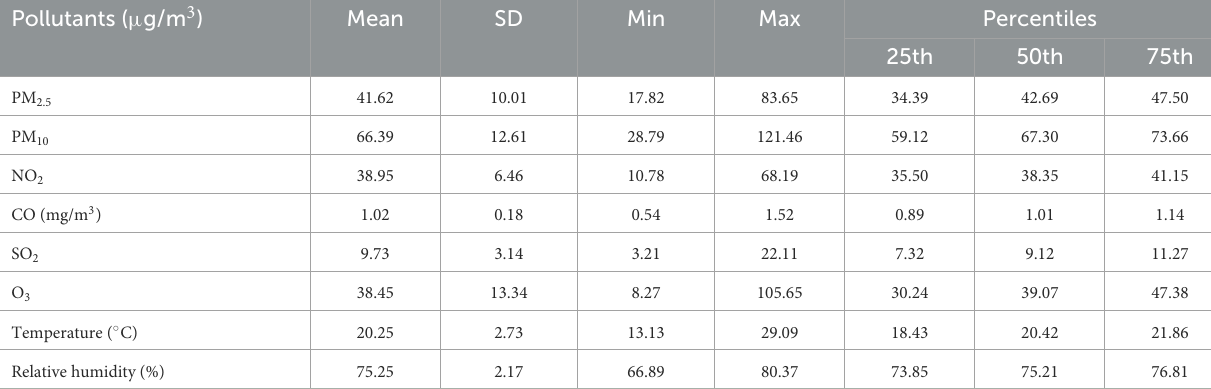
TABLE 2 Descriptive summary of air pollutants and meteorological factors in the study area. Pollutants ( µ g/m 3 )